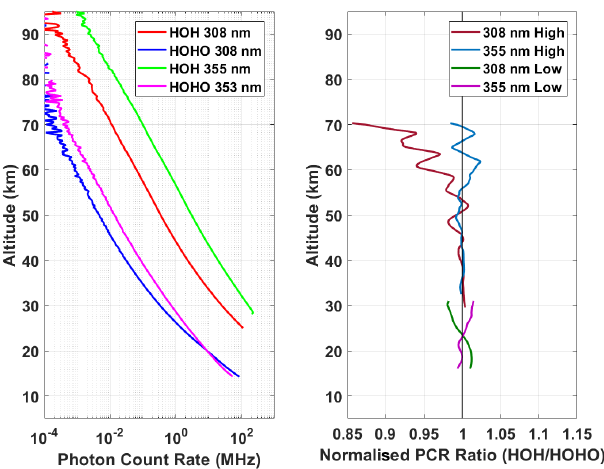
Figure 2. High-gain signals for the HOH and HOHO lidars showing higher signal levels in the newly improved HOH lidar. Ratios of high- and low-gain signals for the HOH and HOHO lidars showing SNR improvement in received signal.